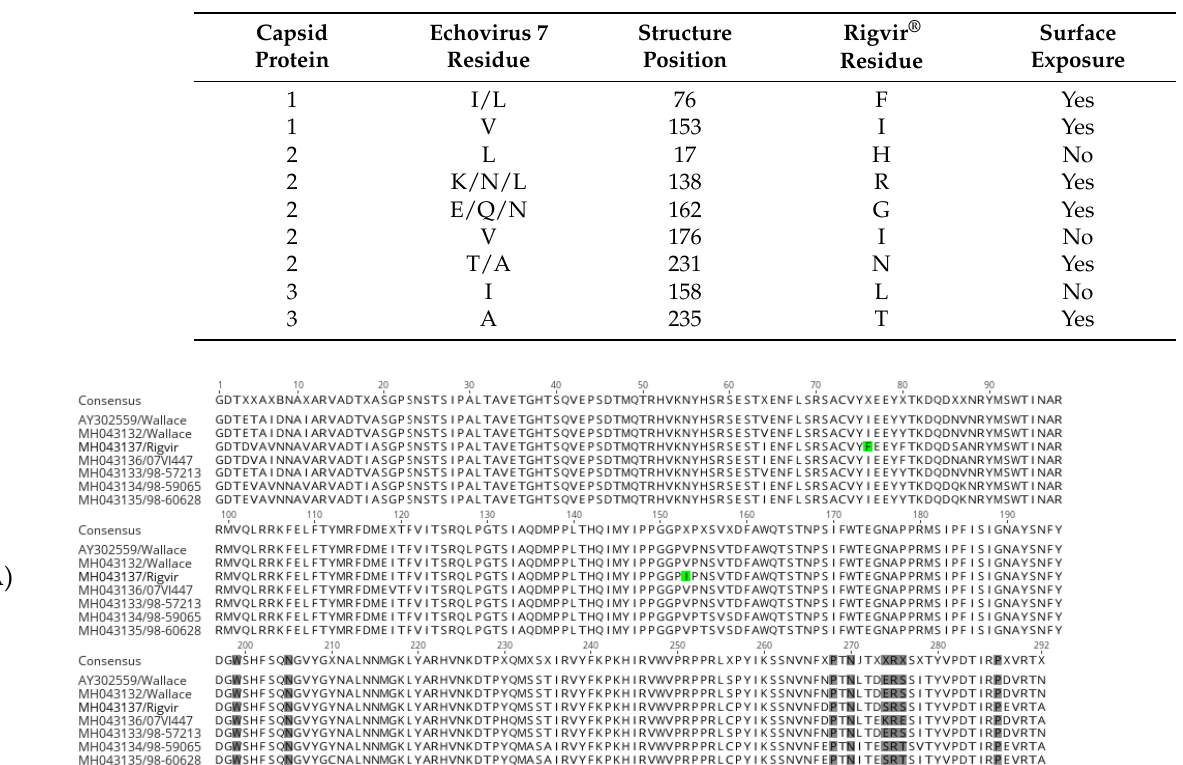
( C ) Figure 2. Protein sequence alignment of E7 capsid proteins: ( A ) VP1, ( B ) VP2, and ( C ) VP3. Positions shaded grey are residues that form direct contact with decay-accelerating factor (DAF). Unique mu- tations found in Rigvir ® are colored green, and the “puff” and “knob” structural motifs that contain the majority of DAF contact residues are colored orange. 3.2. Structural Analysis of DAF Binding Site The previous sequence and phylogenetic analyses were suggestive of some potential differences between Rigvir ® and other E7 isolates, which may further indicate differences in their ability to bind and infect cancer cell lines. To further examine the mutations pre- sent in Rigvir ® ’s capsid proteins, the discovered mutations were mapped onto the E7 crys- tal structure (PDB ID 2X5I) (Figure 3). Six mutations were found to have surface exposure on the cytoplasmic side (Figure 3B, Table 1). Additionally, two of these mutations, E/Q/N162G and K/L/N138R, were found to be in the previously described “puff” region of the VP2 capsid protein (Figure 3B). T he “puff” and “knob” regions were previously